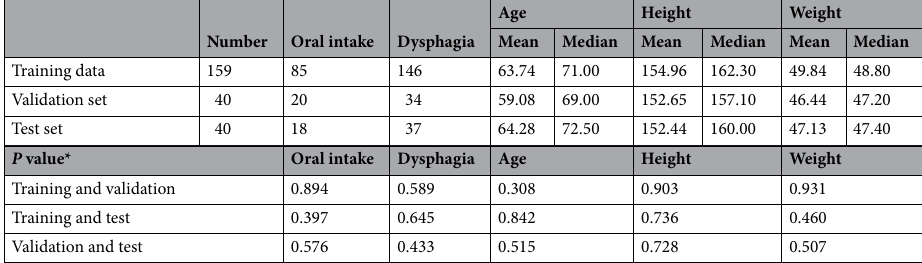
2 test was used for oral intake and dysphagia, and t test for other